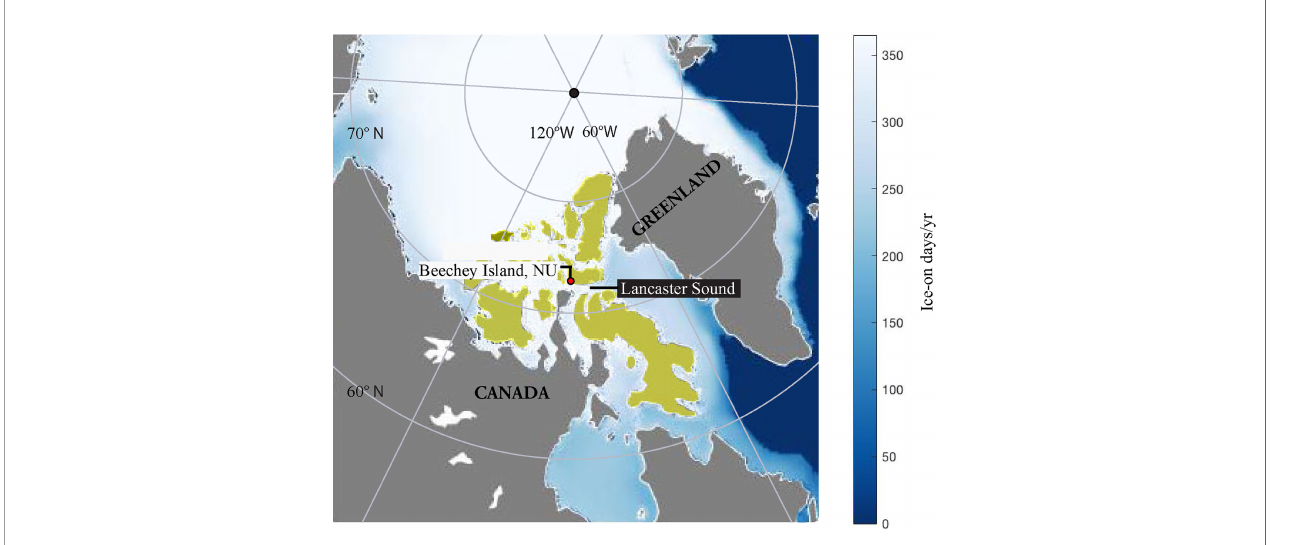
FIGURE 3 | Map of Clathromorphum compactum sampling site (Beechey Island; 74°42 ’ 54.46 ” N 91°47 ’ 29.35 ” W) used for this study. Highlighted yellow region comprises Canadian Arctic Archipelago. Gradient of blue indicates duration of ice cover (ice-on days: <15% SIC) per year (average between 1979-2015). Data sourced from NSIDC daily SIC dataset (25 km 2